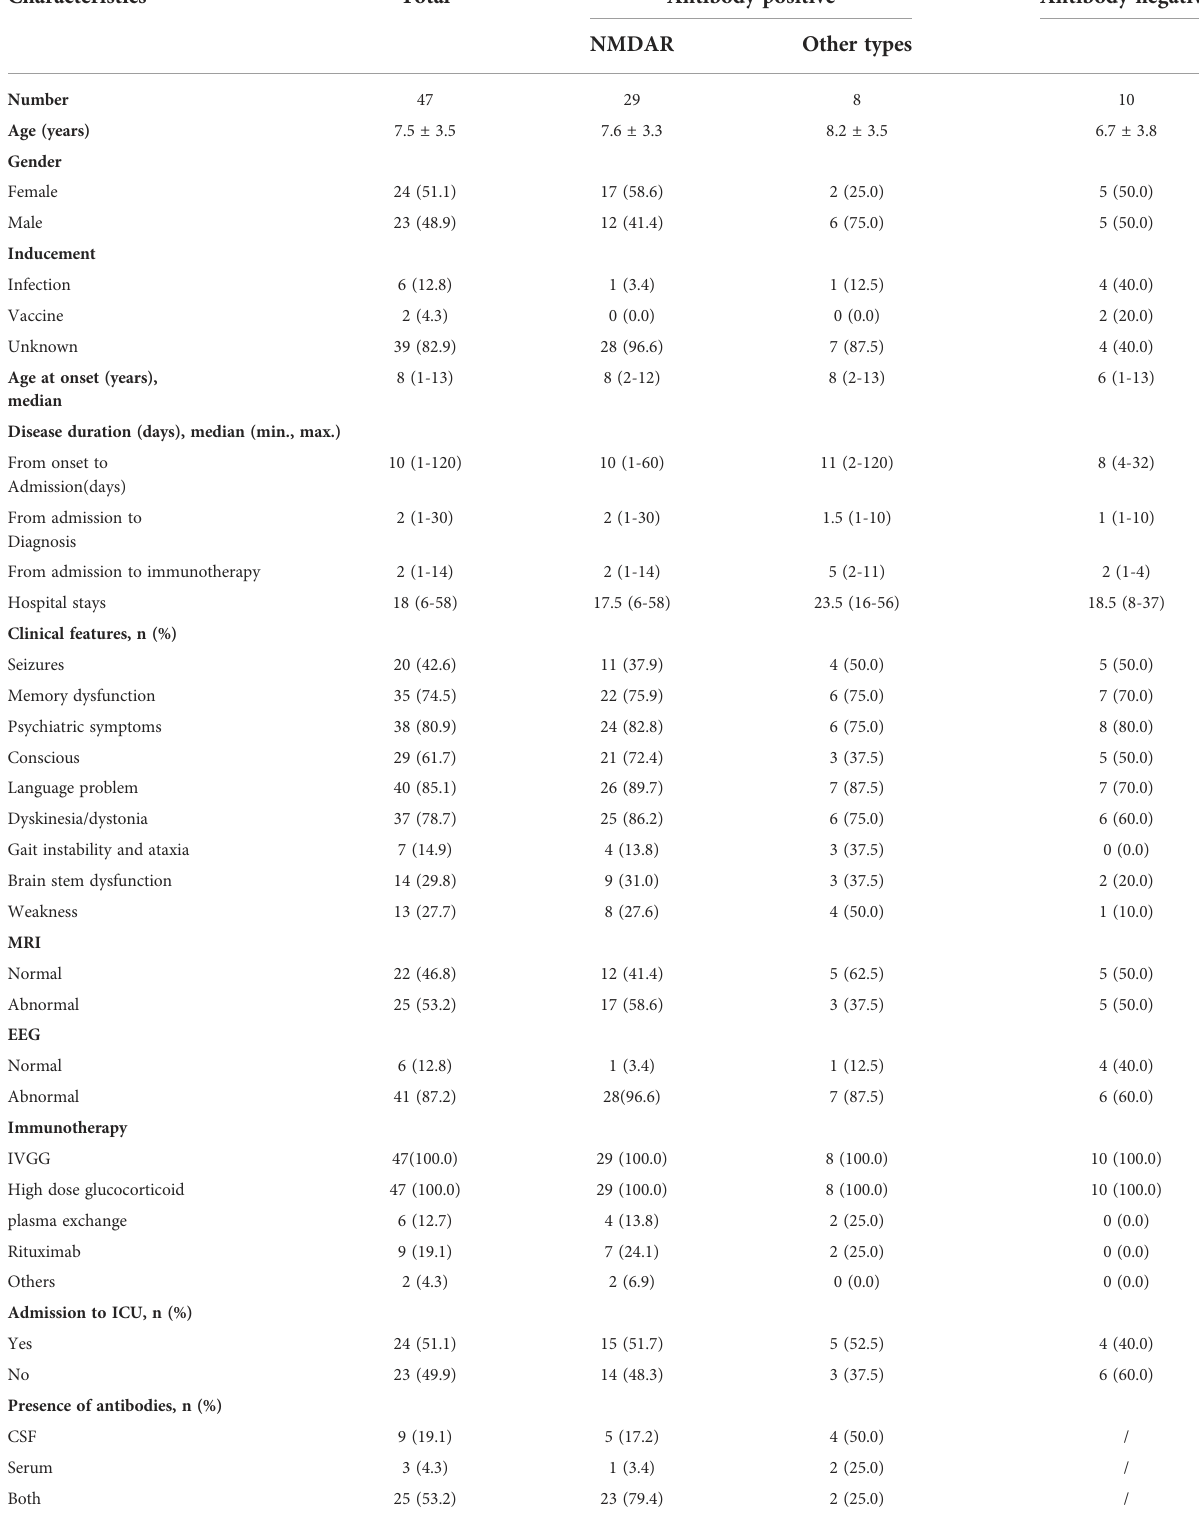
TABLE 1 Demographic and clinical characteristics of enrolled patients with autoimmune encephalitis (N, mean ± SD, median,